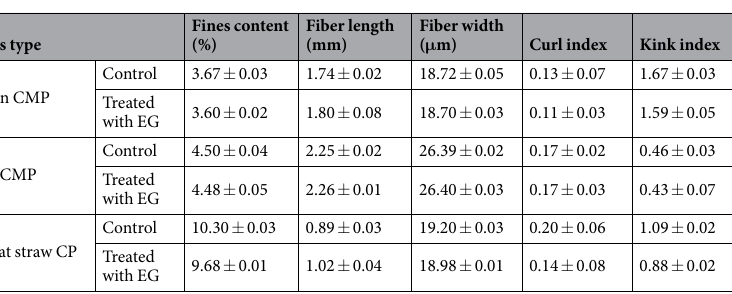
Table 4. Physical characteristics of fiber in various pulps treated with the EG from engineering strain